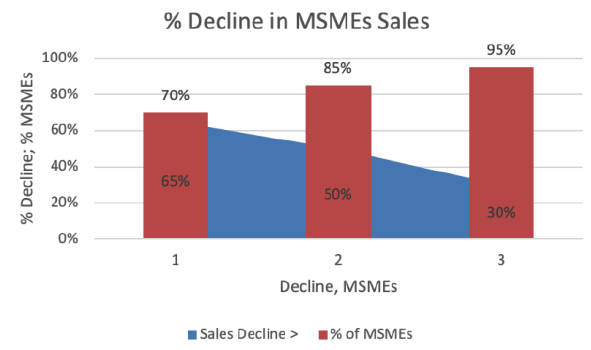
Figure 1: Decline of sales during COVID-19 Period